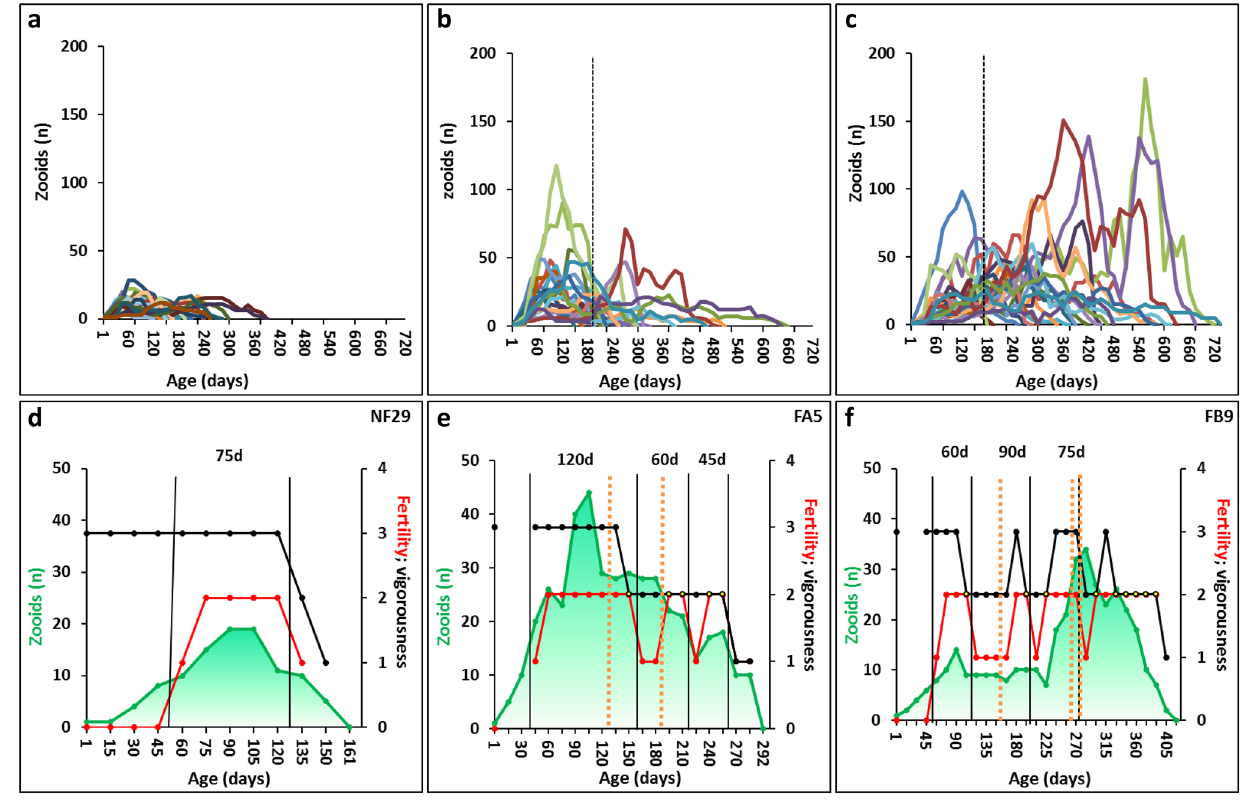
Figure 2. Life-history traits of the three strategies ( a – c ). Number of zooids in up to 17 data-collection sessions during the life spans of each of the 81 Botryllus colonies studied. The colonies are grouped into the three life- history strategies: ( a ) NF; ( b ) FA; ( c ) FB. The dashed vertical lines in ( b ) and ( c ) depict average ages for the first fission. ( d – f ) A typified representative of each of the three life-history strategies. ( d ) Colony NF29 as an example of the non-fission (NF) strategy. ( e ) Colony FA5 as an example for fission after zooids reach peak size (FA). ( f ) Colony FB9 as an example of fission before zooids reach peak size (FB). Life-history traits presented: the numbers of zooids (green curve), RS scores (red curve) and CV scores (black curve). Vertical black lines outline RS segments (RSS), with the length (days) marked for each RS segment. Vertical dotted orange lines depict fission